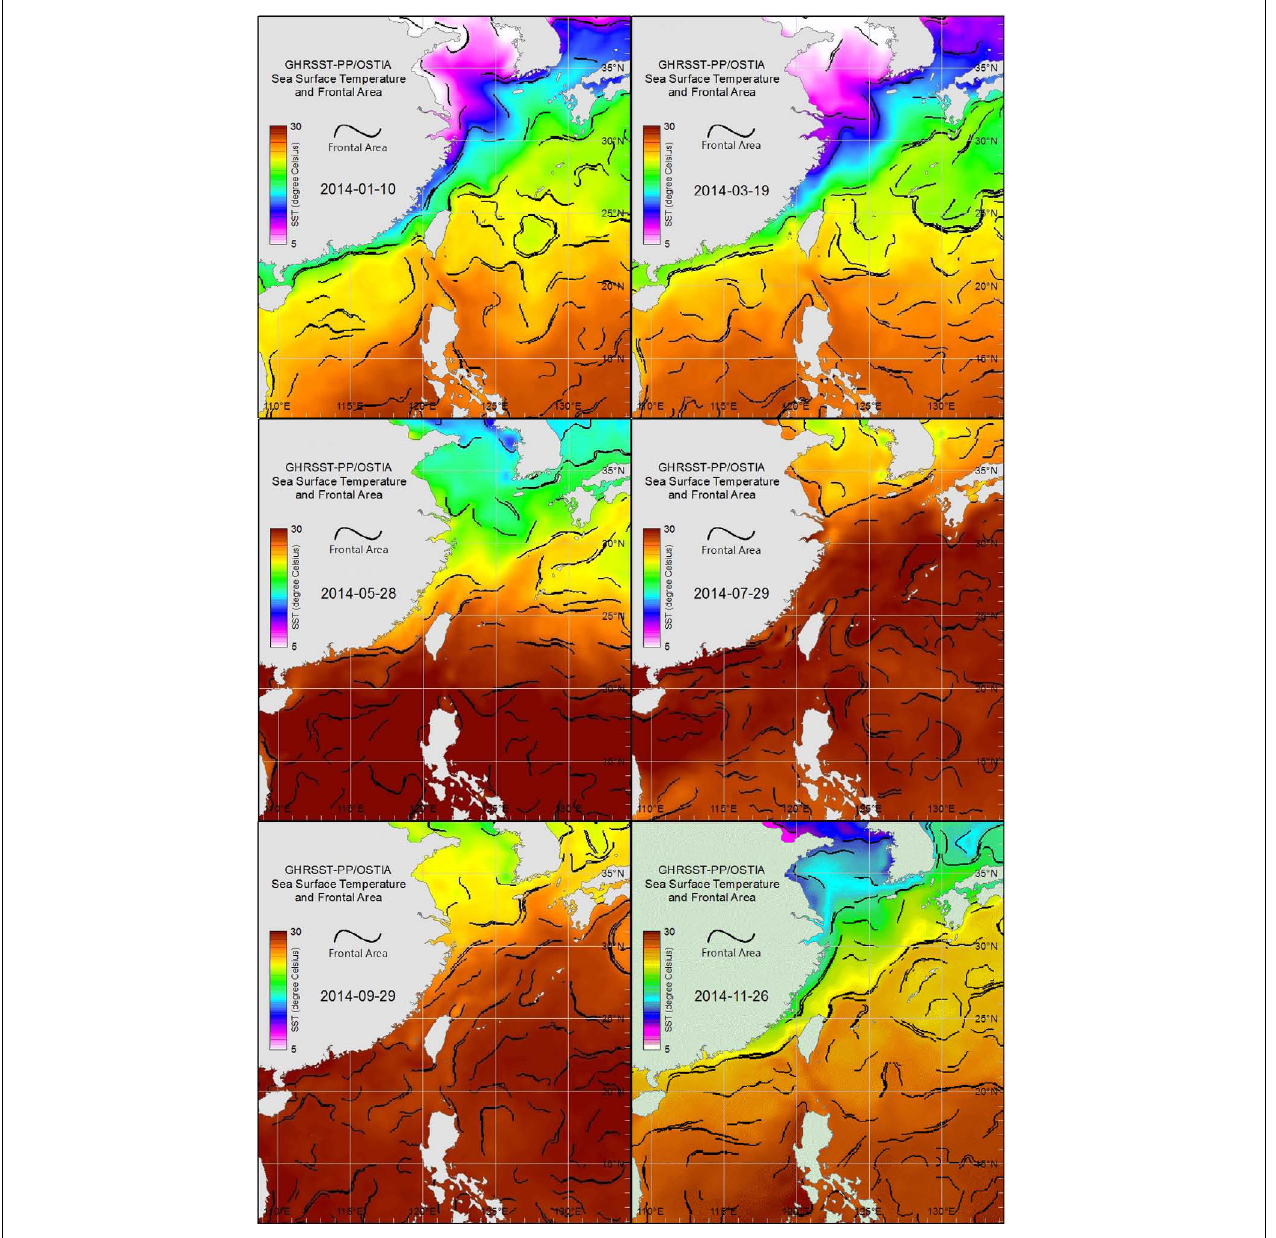
FIGURE 2 | Sea surface water-temperature images for each bimonthly sampling date in 2014 derived from GHRSST-PP/OSTIA, showing water mass distributions in the East China Sea, Taiwan Strait, and South China Sea.